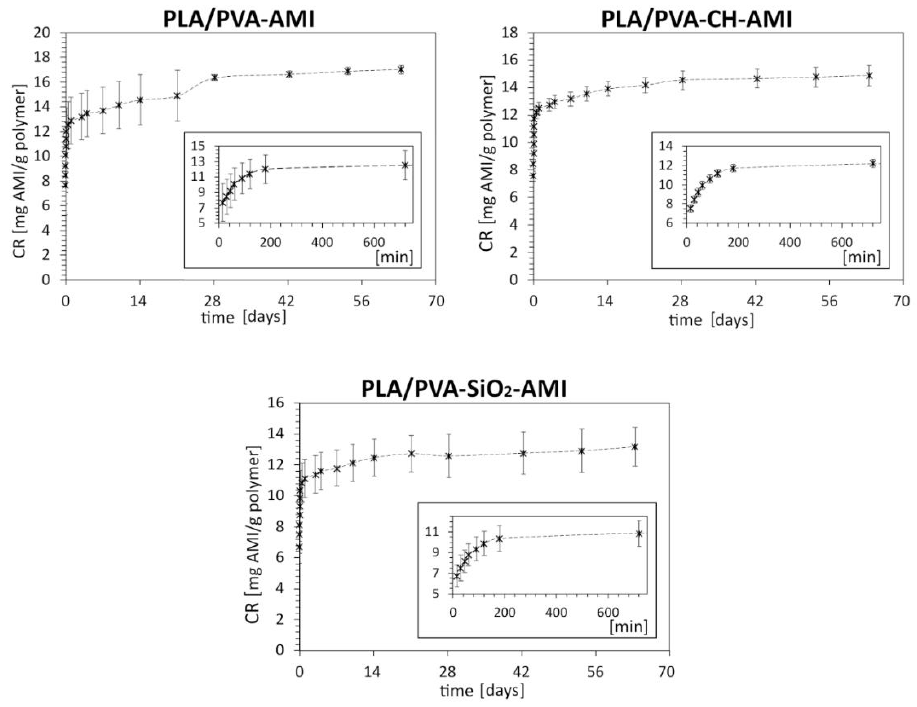
Figure 4. Amikacin release from the PLA/PVA, PLA/PVA-CH, and PLA/PVA-SiO 2 porous matrices ( n = 3); the smaller plots show the initial phase of the release process.